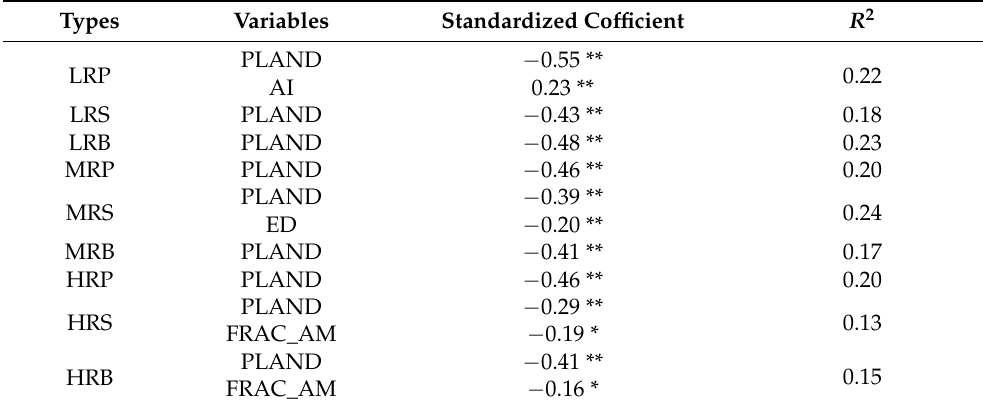
Table 5. Impacts of composition and configuration variables of UGS on LST among different urban